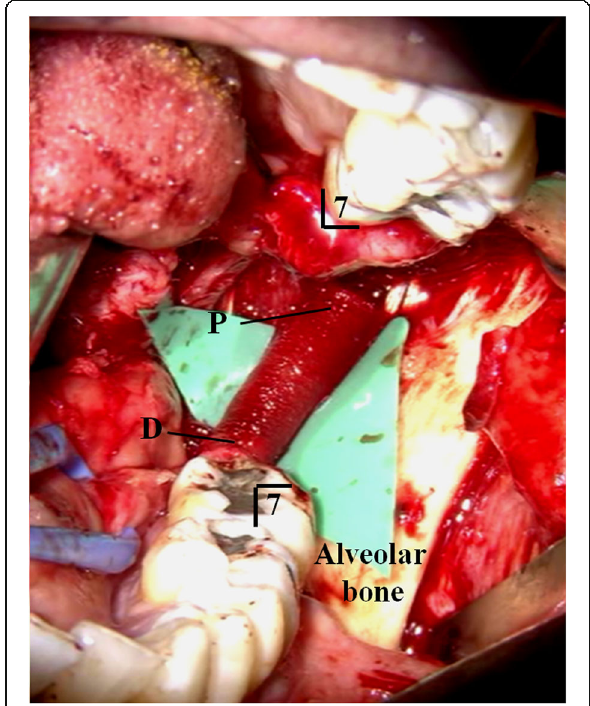
Fig. 3 Sutured LN through allograft nerve (RENERVE®).